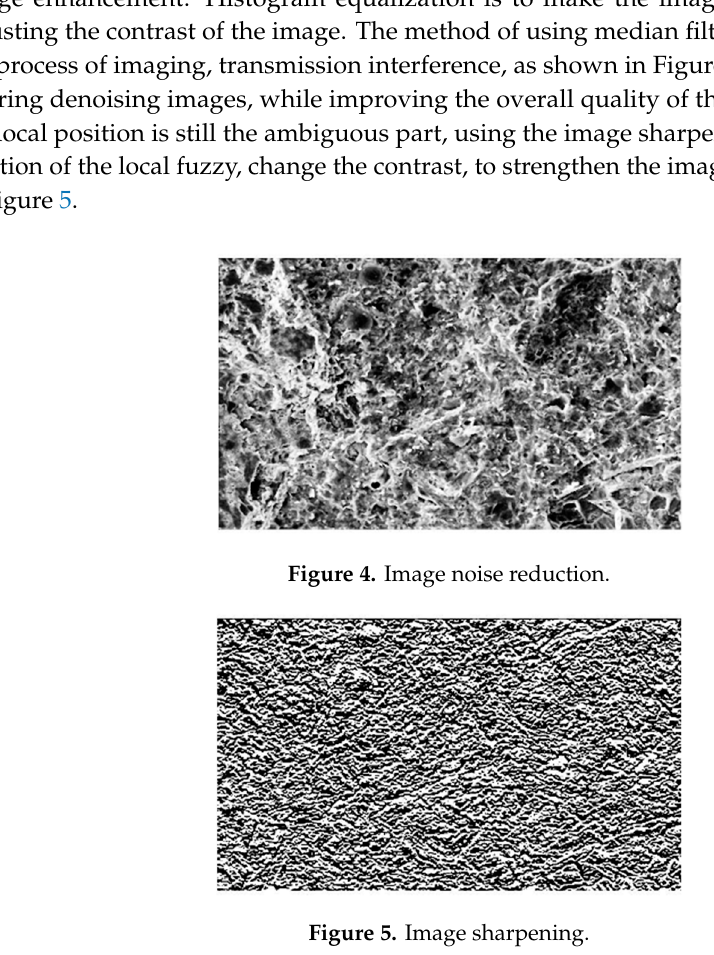
Figure 5. Image sharpening.